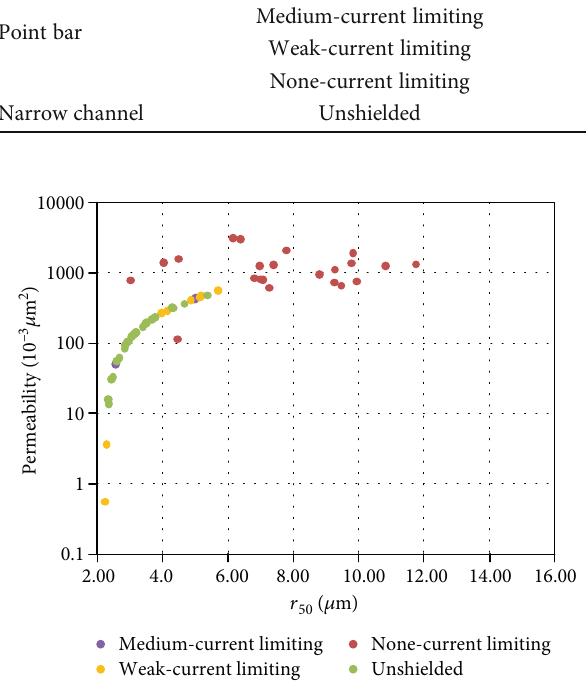
Figure 13: Scatter plot of permeability and r units.